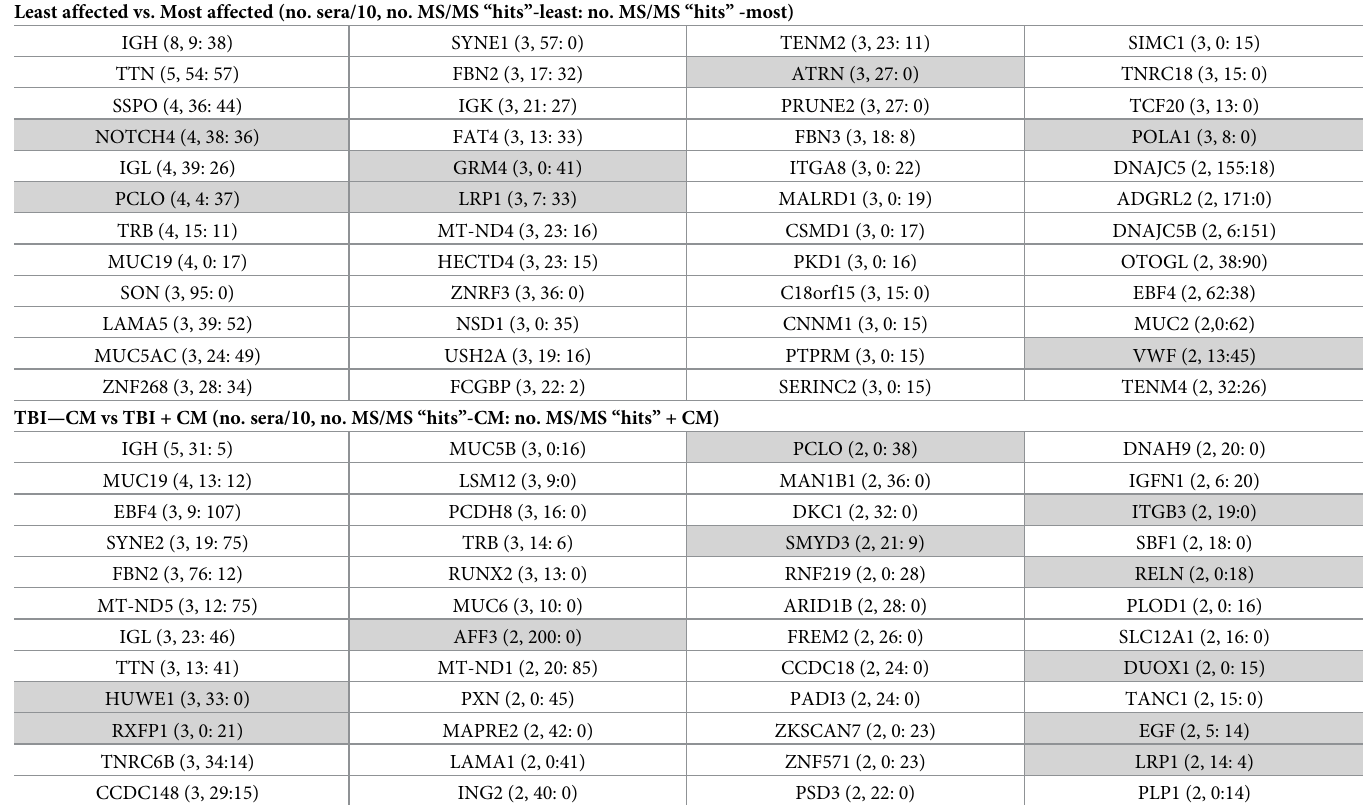
Table 3. Peptides/proteins identified using LOOCV discriminatory mass peaks in TBI+PTSD+CM+SDep versus controls and TBI+CM versus TBI. Least affected vs. Most affected (no. sera/10, no. MS/MS “hits”-least: no. MS/MS “hits”